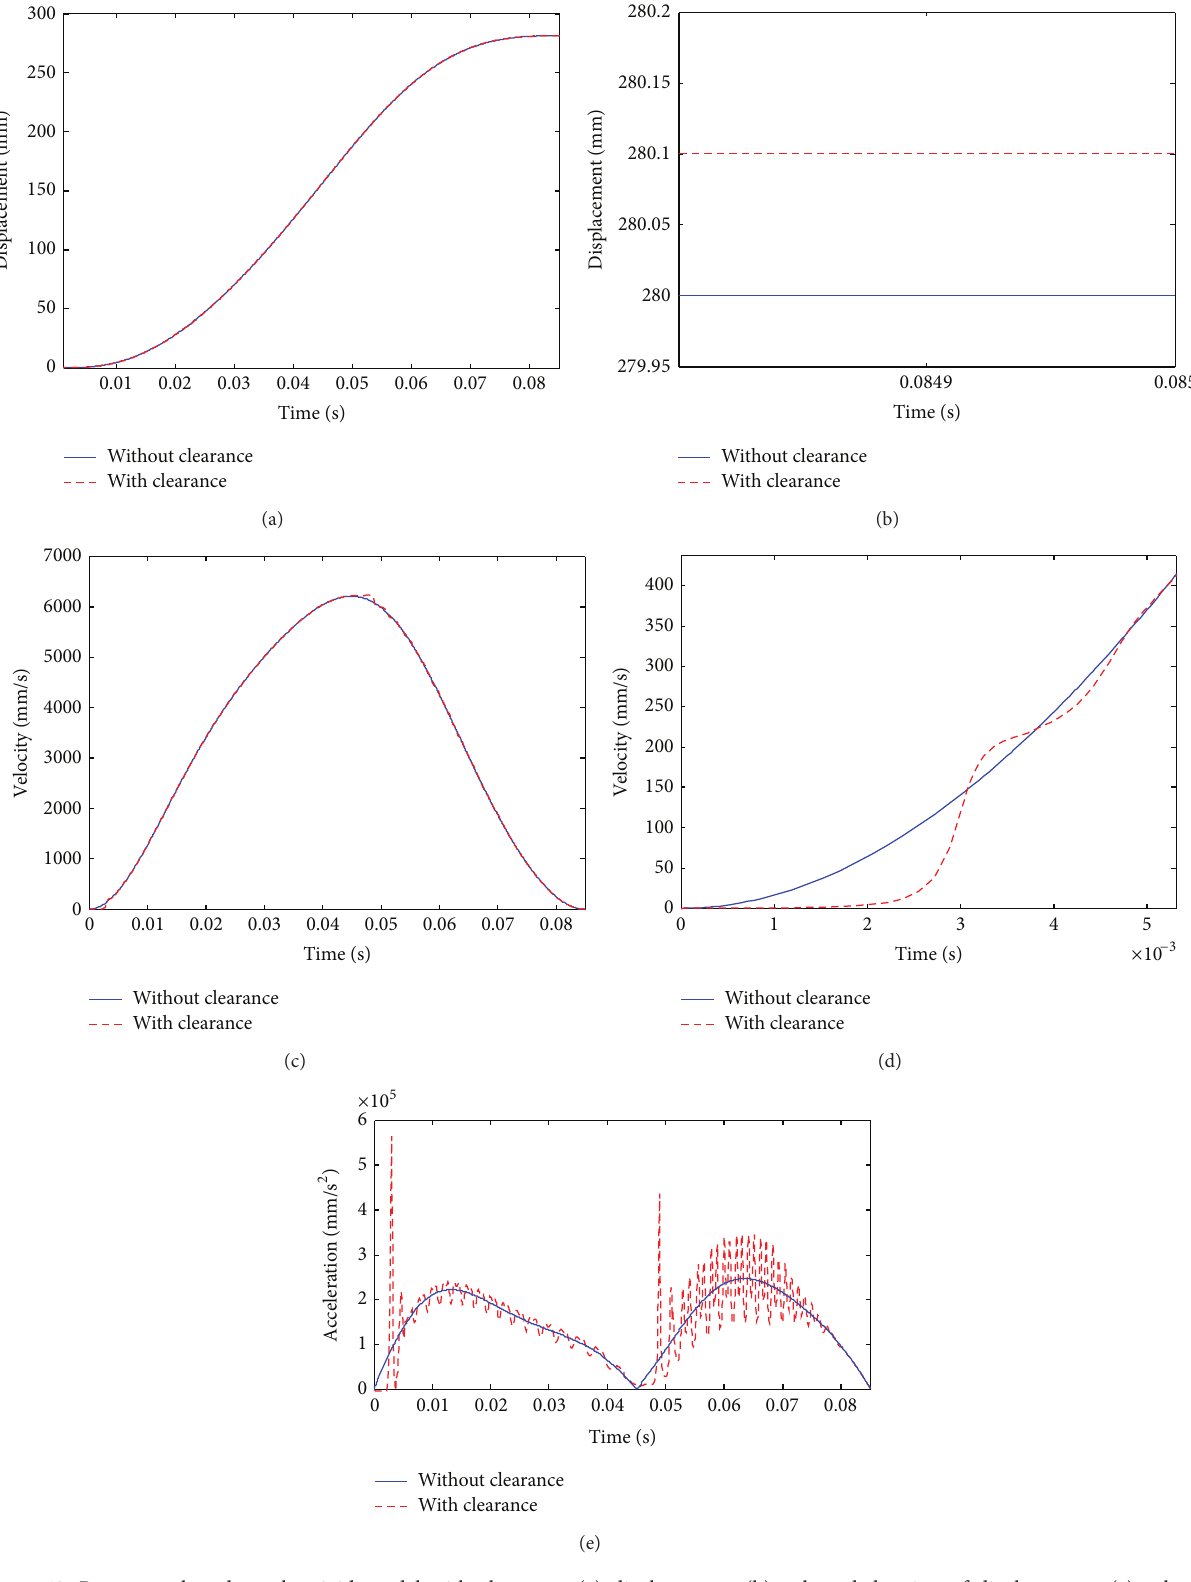
Figure 13: Responses based on the rigid model with clearance: (a) displacement, (b) enlarged drawing of displacement, (c) velocity, (d) enlarged drawing of velocity, and (e)